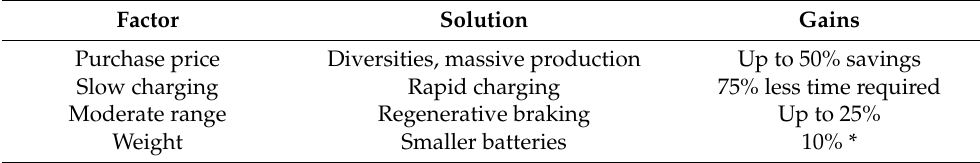
Table 3. Factors concerning EV adoption and their solution [30–32]. Factor Solution Gains Purchase price Diversities, massive production Up to 50% savings Slow charging Rapid charging 75% less time required Moderate range Regenerative braking Up to 25% Weight Smaller batteries 10%